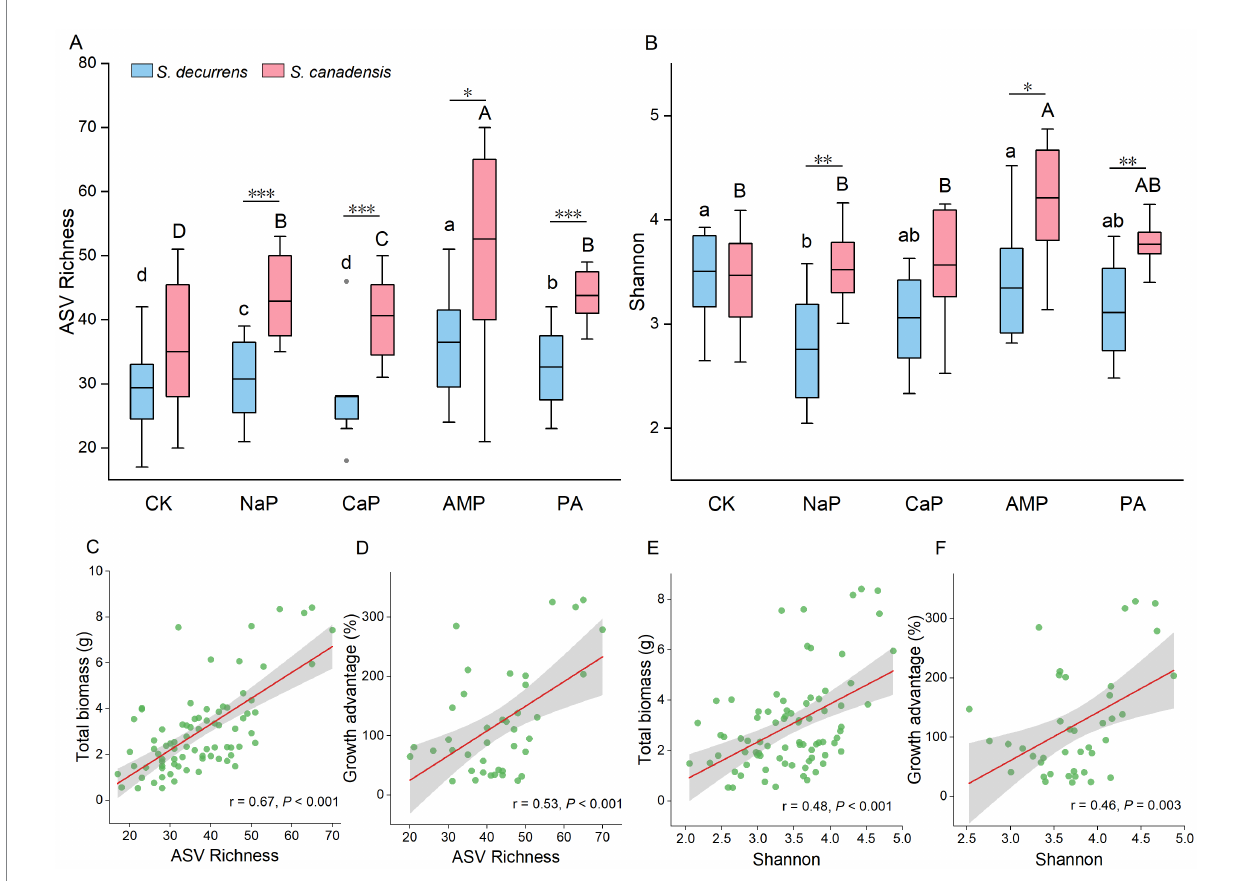
FIGURE 2 The variation of arbuscular mycorrhizal fungi (AMF) (A) ASV richness and (B) Shannon index in the rhizosphere soil of S. decurrens and S. canadensis under five P treatments. CK: no P addition; NaP: sodium dihydrogen phosphate; CaP: hydroxyapatite; AMP: adenosine monophosphate; PA: myo- inositol hexakisphosphate. The line in the box represents the median value, box boundaries indicate values in the 25–75th percentile range, whiskers indicate the 95% confidence intervals. The different lower-case letters among S. decurrens and different upper-case letters among S. canadensis denote significant differences at p < 0.05. The asterisks denote difference between S. decurrens and S. canadensis in the same P treatment. * p < 0.05, ** p < 0.01, *** p < 0.001. Pearson correlations between ASV richness and (C) plant growth, (D) growth advantage of S. canadensis over S. decurrens , Shannon index and (E) plant growth, (F) growth advantage of S. canadensis over S. decurrens . The gray ribbons represent the 95% confidence